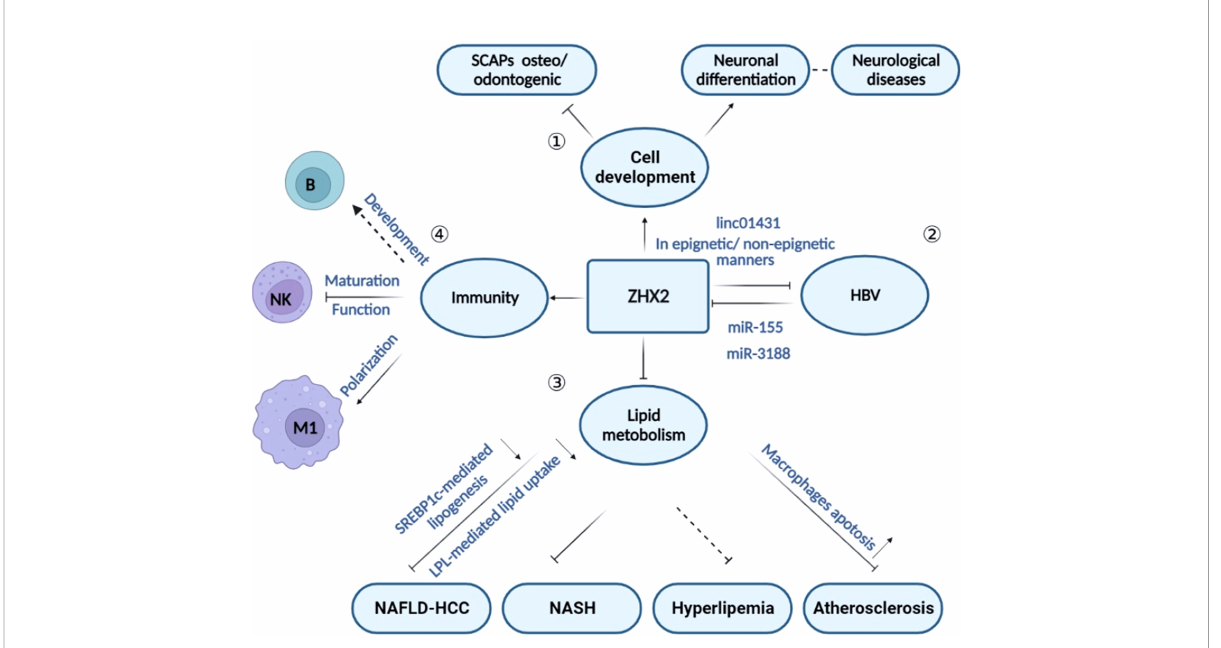
FIGURE 3 The role of ZHX2 in different physiological and pathological processes. ① Through regulating cell development, ZHX2 is implicated in inhibiting neuronal differentiation and promoting osteo/odontogenic differentiation of stem cells from SCAPs. ② ZHX2 restricts HBV replication via CBP/p300 and linc01431-mediated epigenetic repression or via inhibiting viral promoter activity in non-epigenetic manners. However, HBx protein reduces ZHX2 expression by upregulating miR-155 and miR-3188 expression. ③ ZHX2 is a critical regulator in lipid hemostasis and plays roles in atherosclerosis, NASH, and NAFLD-HCC progress. ④ ZHX2 is involved in immune regulation by in fl uencing the development of multiple immune cell